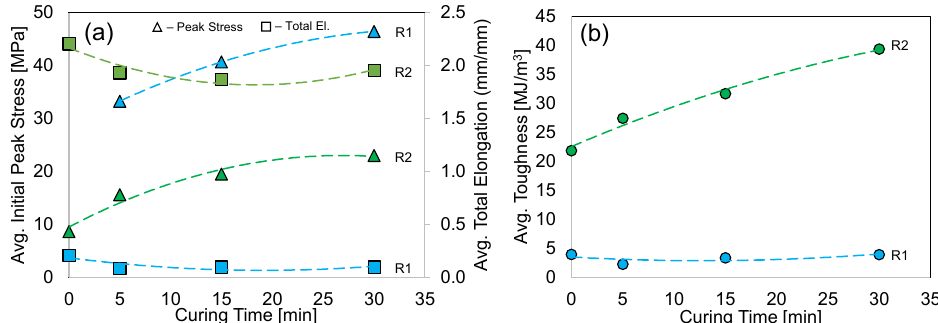
Figure 9. The effect of curing time on the uniaxial tensile performance of Resin 1 (R1) and Resin 2 (R2): ( a ) average initial peak stress and total elongation strain; ( b ) average toughness, computed from the tensile stress–strain curves. Regression analysis was used to fit polynomial trendlines to the data.